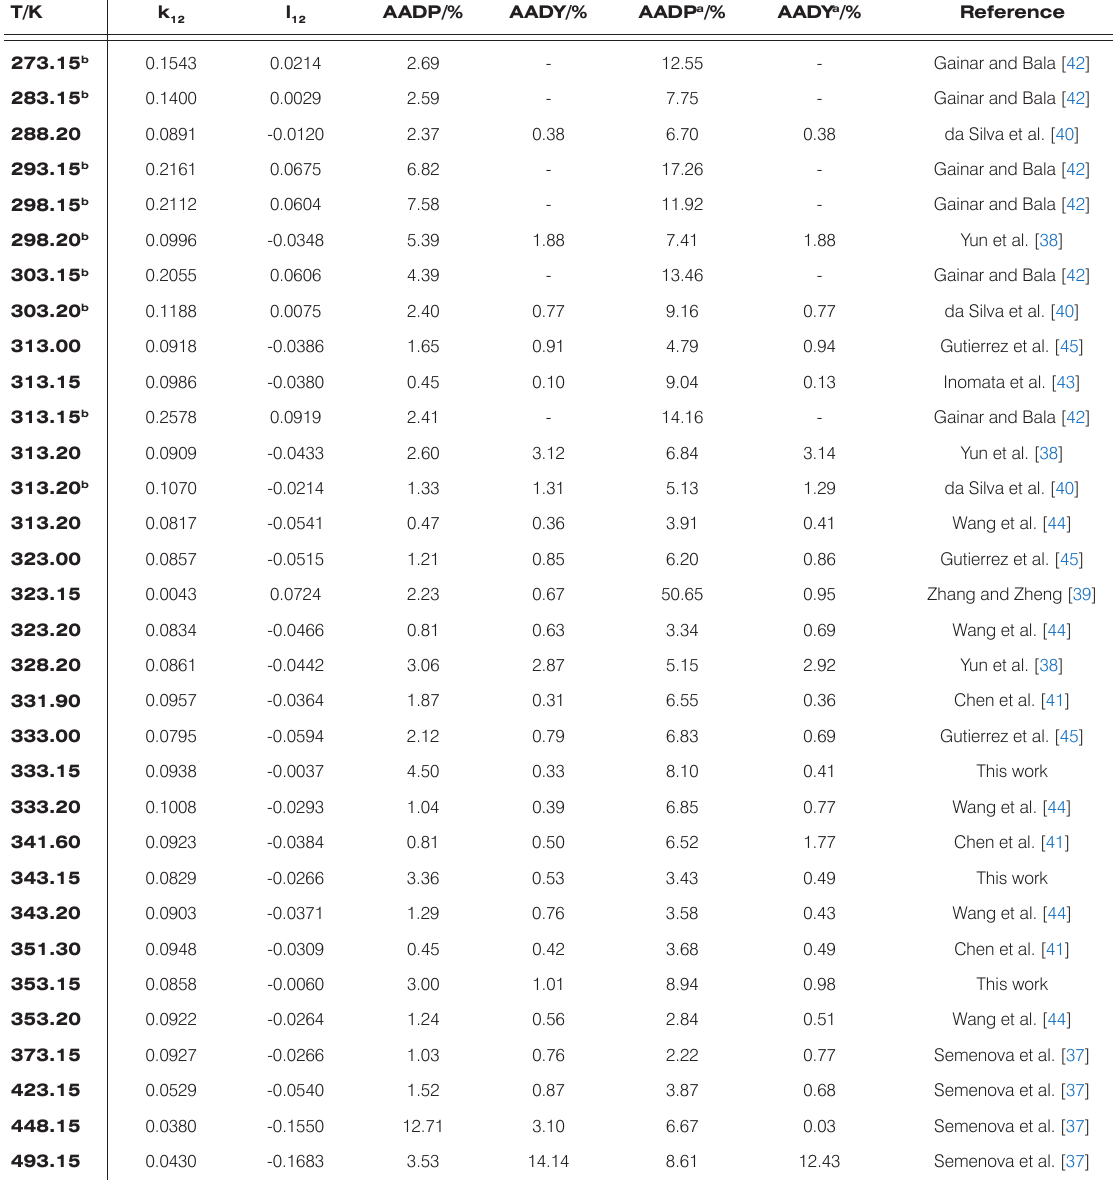
, l ), average absolute deviations in bubble point pressure ( AADP /%), and average absolute 12 12